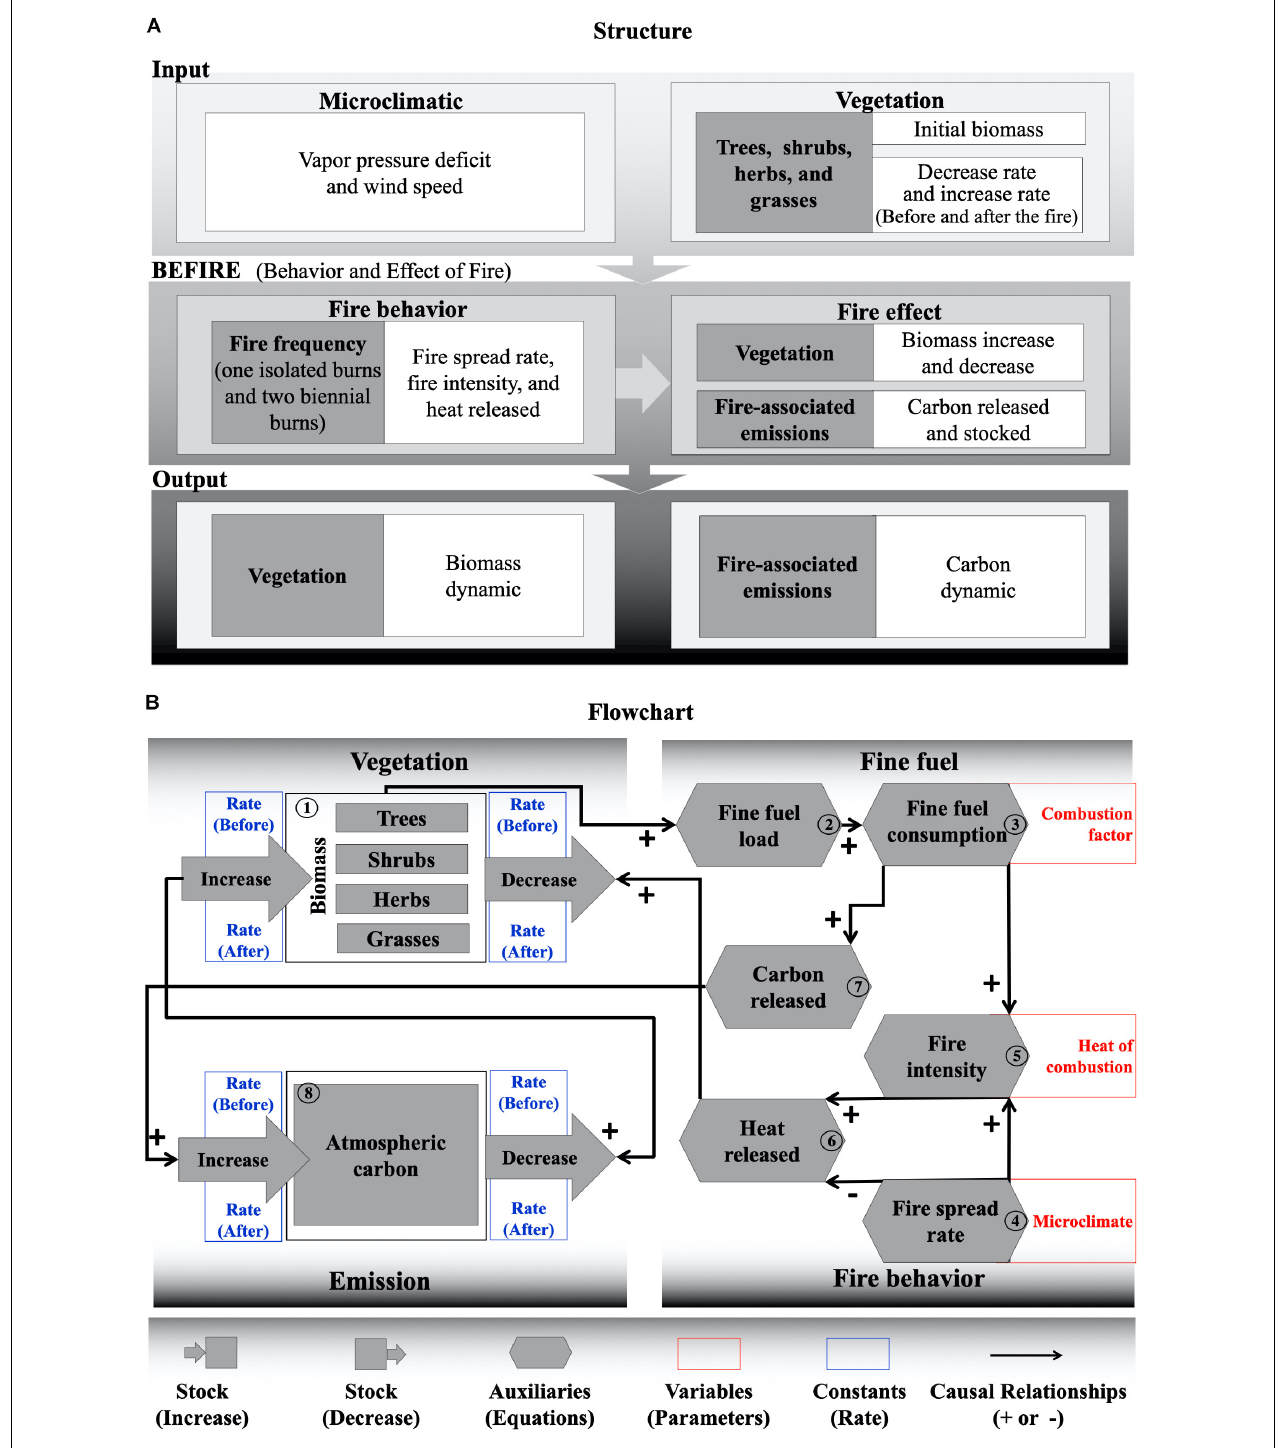
FIGURE 2 | (A) Structure and (B) flowchart of the BEFIRE model. The numbers represent the steps of the model (online version in color).